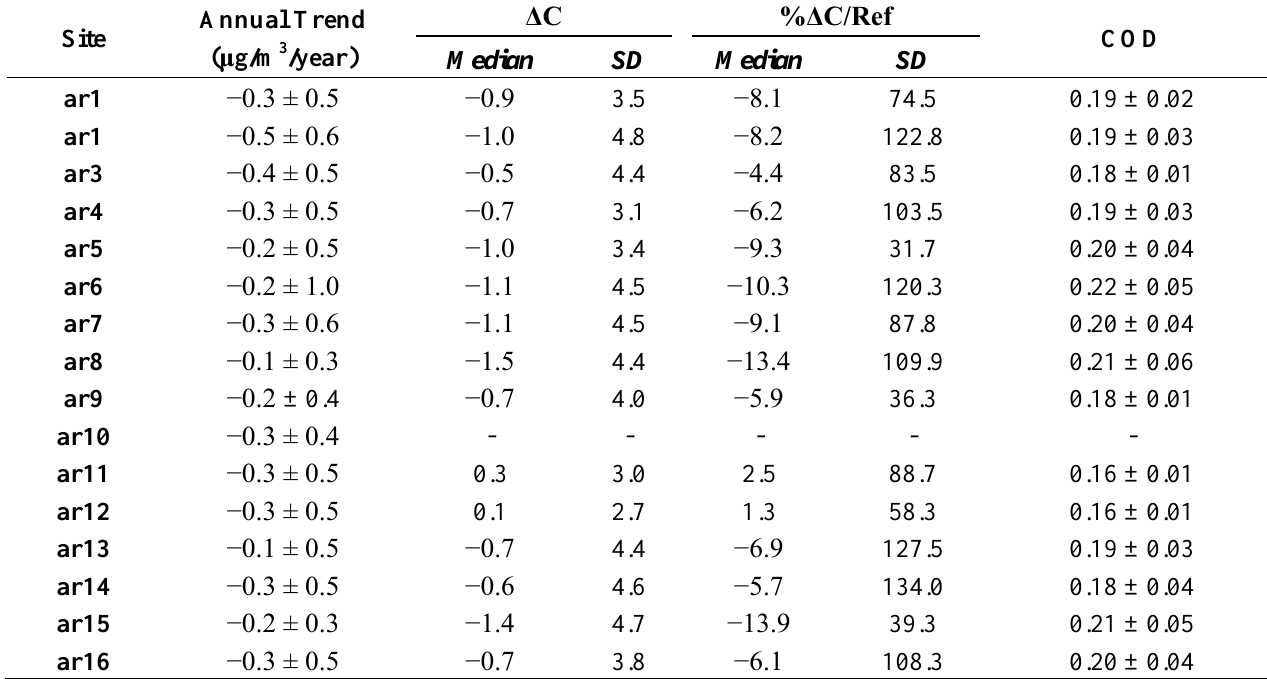
Table 1. The PM annual trends (mean ± st.error), absolute (ΔC) and relative (%ΔC/Ref) 2.5 concentration differences (compared to the “ar10” site) and the COD ratio (mean ± standard error) in Arkansas monitoring